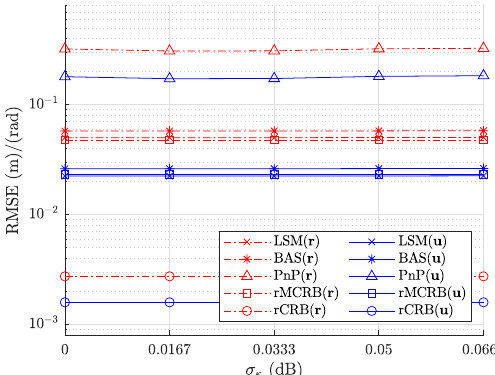
Figure 8. RMSE for position and orientation estimates as a function of σ κ .